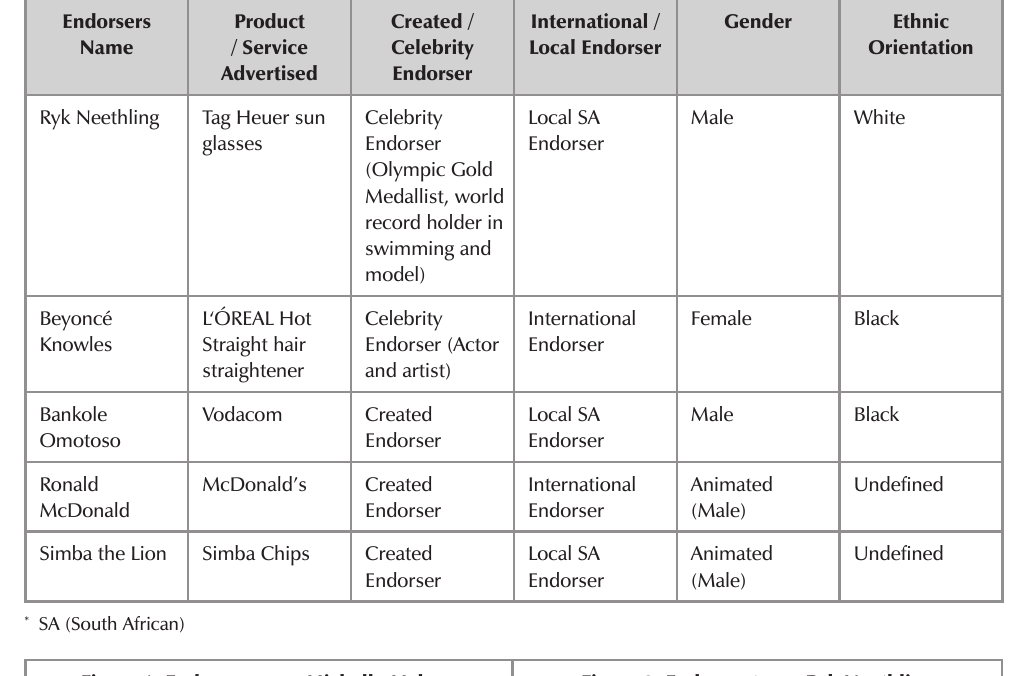
Figure 1: Endorser one – Michelle Mclean Figure 2: Endorser two – Ryk Neethling (Olympic Gold Medallist and